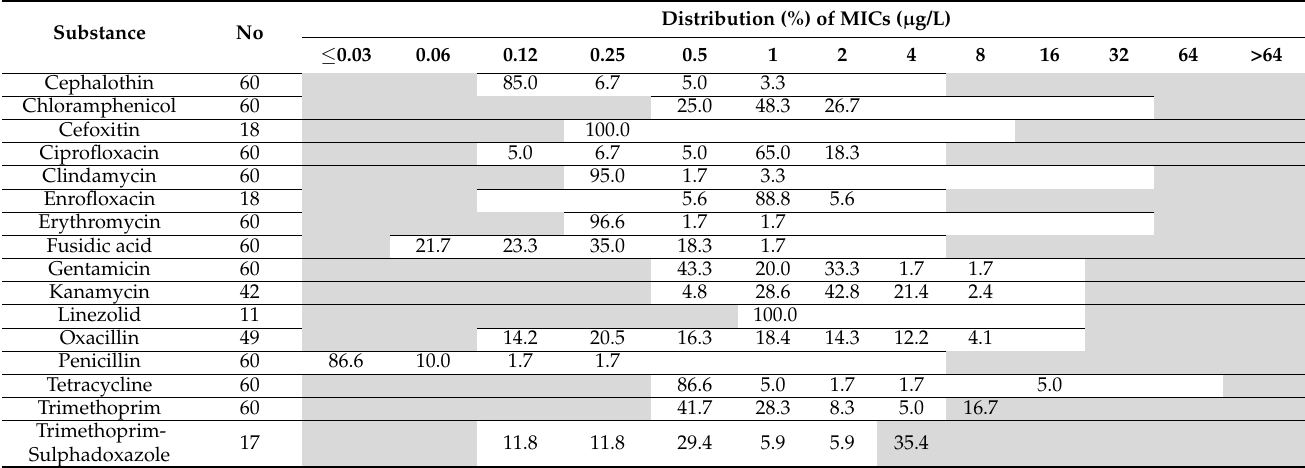
Table 5. Number of tested isolates (No) and MIC distribution (%) for Trueperella pyogenes ( n = 60) from clinical mastitis in dairy cows. White fields indicate test range for each